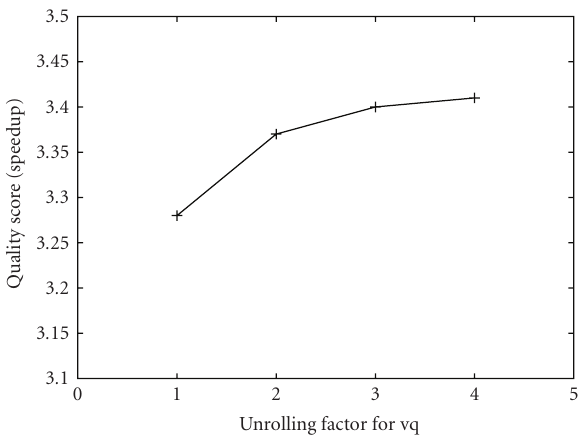
Figure 8: Quality scores (speedups) for di ff erent unrolling factors of vector quantisation.